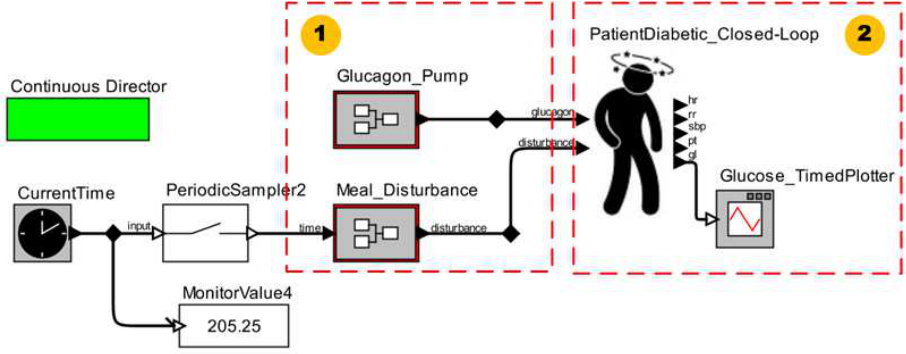
Figure 21. MCPS Model Using a Diabetic Patient Model.